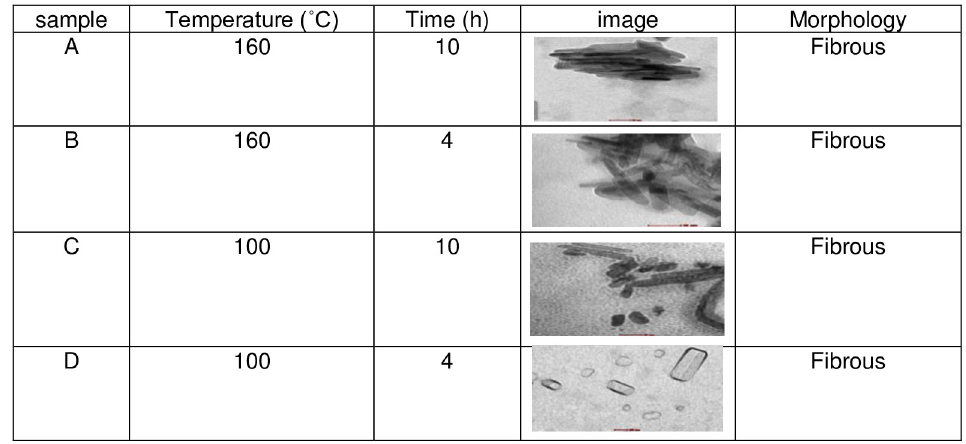
Fig 4. TEM images for HAp samples in acidic conditions (pH = 4).